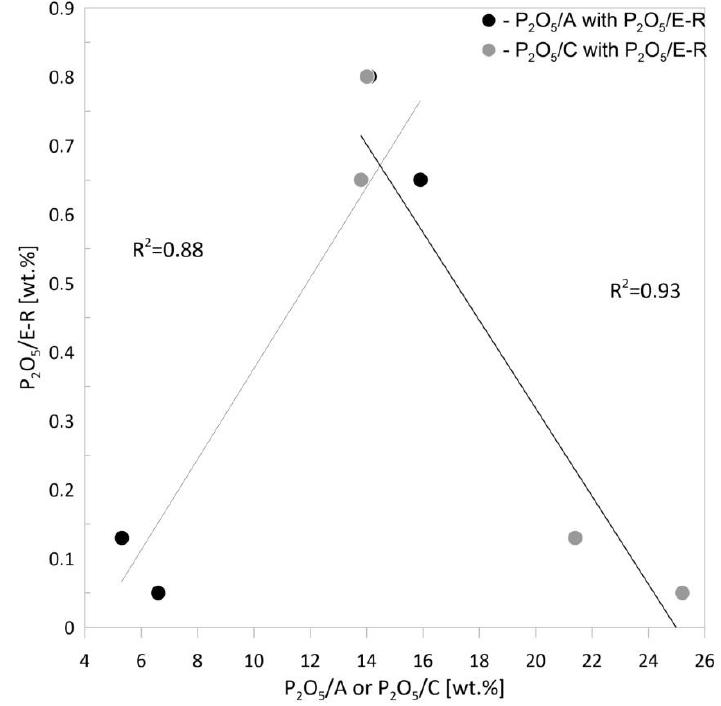
Figure 11. The relationship between the phosphorus content in the amorphous phase (P 2 O 5 /A) or crystalline (P 2 O 5 /C) and the content of phosphorus soluble in a 0.04 M solution of calcium lactate (P 2 O 5 /E-R).